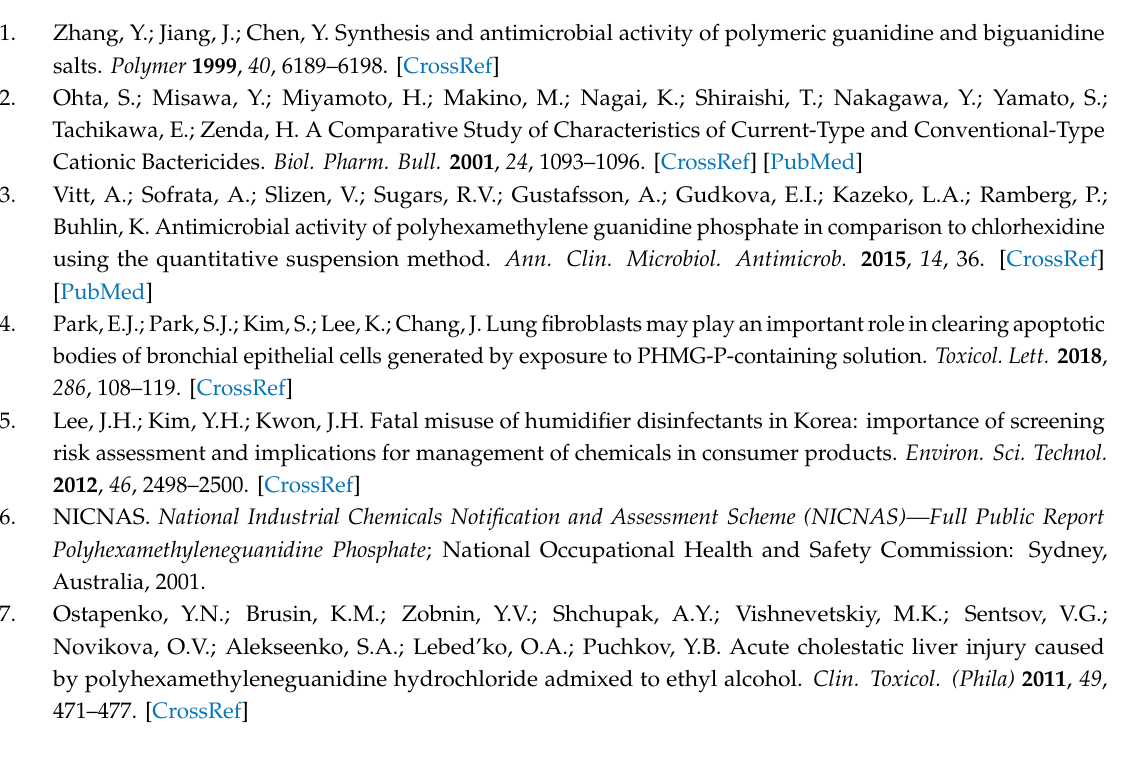
Figure S1: Morphological images as groups during embryogenesis under 0 to 2 mg / L PHMG-P exposure, Table S1: List of primers for real-time